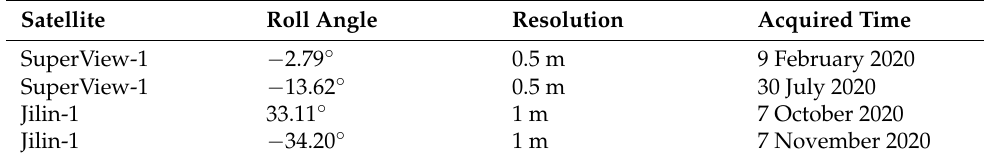
Table 1. Detailed information of used remote sensing images acquired from different satellites. Satellite Roll Angle Resolution Acquired Time